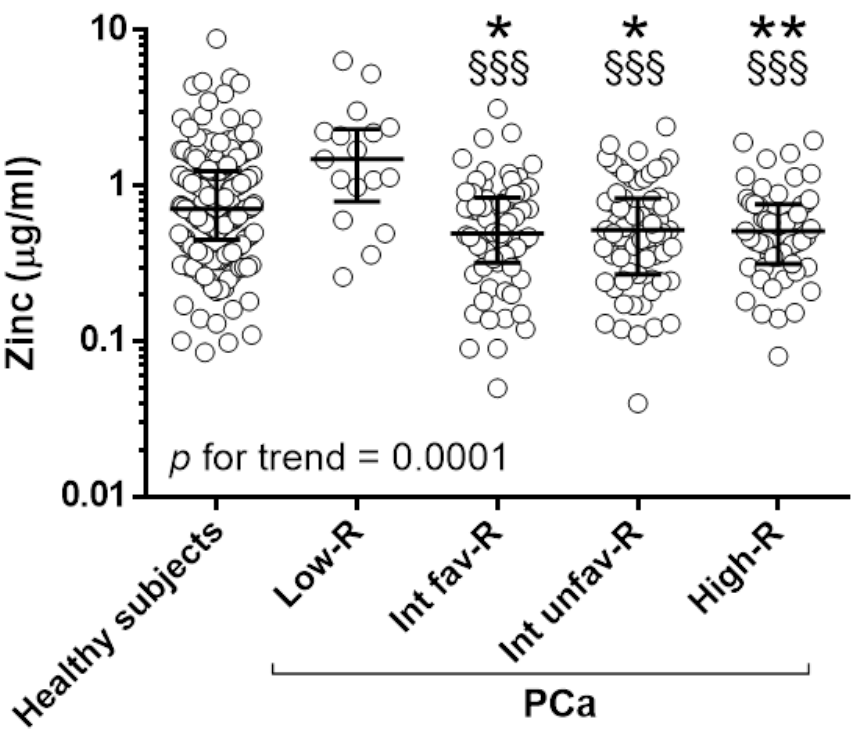
Figure 1. Urinary zinc in healthy individuals and patients with PCa: Zinc in men with no evidence of PCa (Healthy subjects, n = 187), low- (Low-R, n = 17), intermediate-favorable- (Int-fav-R, n = 68), intermediate-unfavorable (Int-unf-R, n = 67), high- (High-R, n = 55) risk patients. * p < 0.05, ** p < 0.01, to healthy subjects. §§§ p < 0.001 to Low-R. p for the trend = 0.0001. Table 2. Urinary zinc expression among healthy subjects and patients.